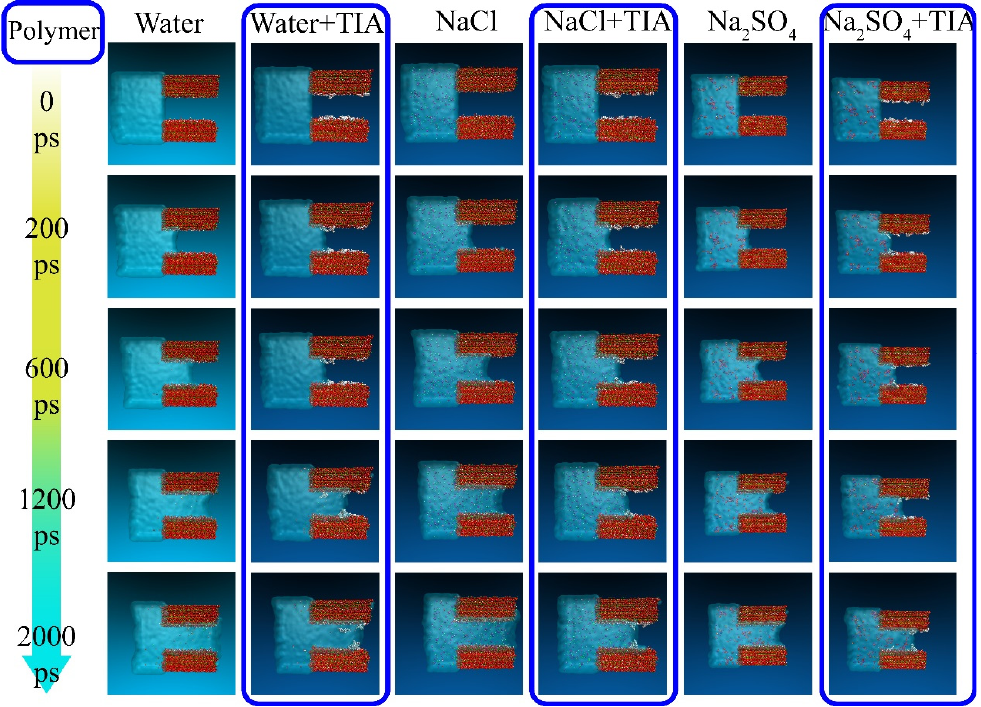
Figure 2. Percolation of various solutions in the C ‐ S ‐ H gel channel (the blue frame indicates that the C ‐ S ‐ H gel contains the TIA polymer). The red, green, yellow, white, gray, purple, bright green and orange spheres represent oxygen atoms, calcium atoms, silicon atoms, hydrogen atoms, carbon at ‐ oms, sodium ions, chloride ions and sulfur atoms, respectively).